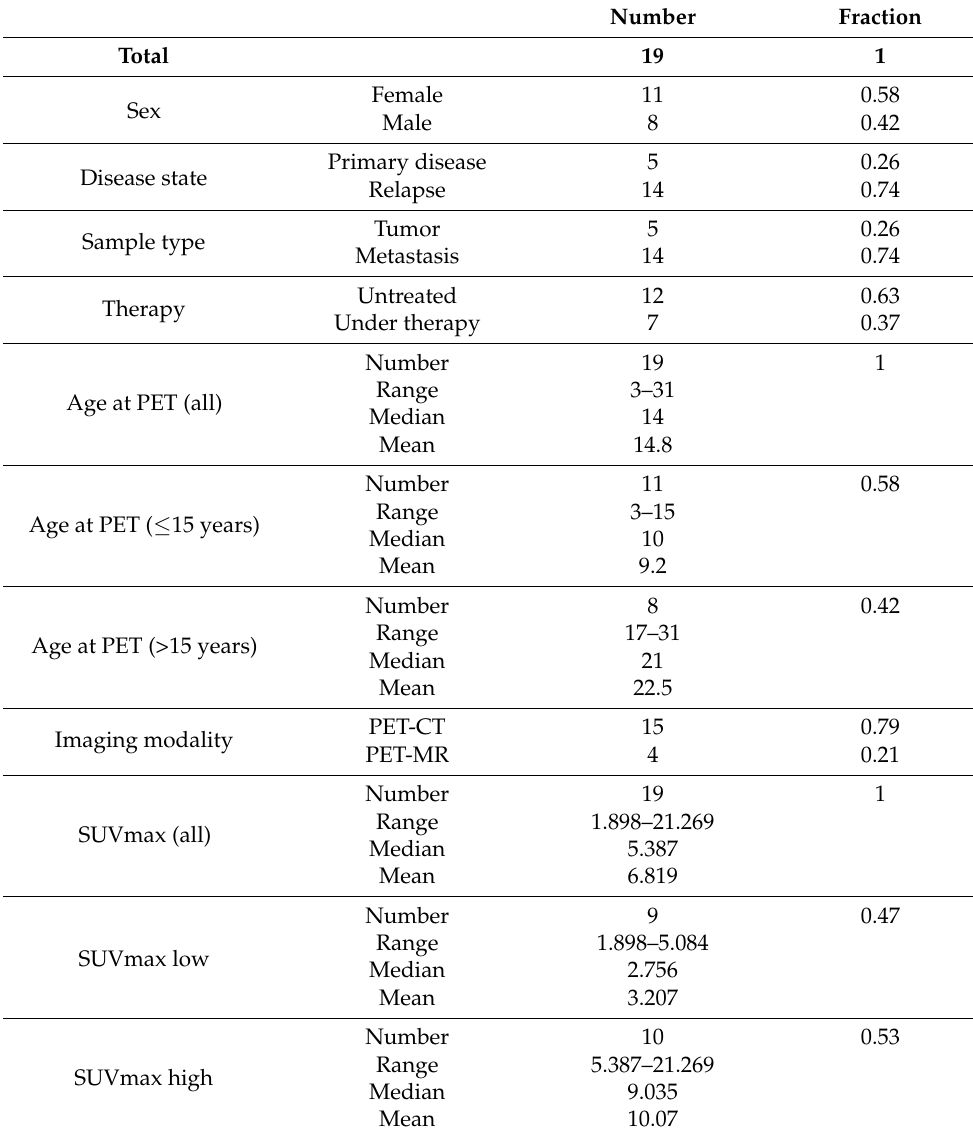
Table 1. Patients’ characteristics of our EwS